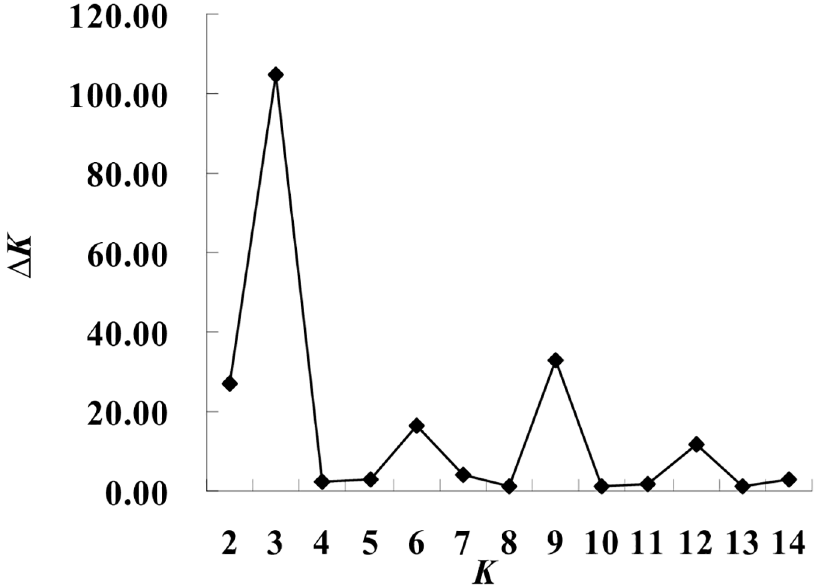
Fig 1. STRUCTURE estimation of the number of subgroups for the K values ranging from 1 to 15, by delta K ( Δ K )values.